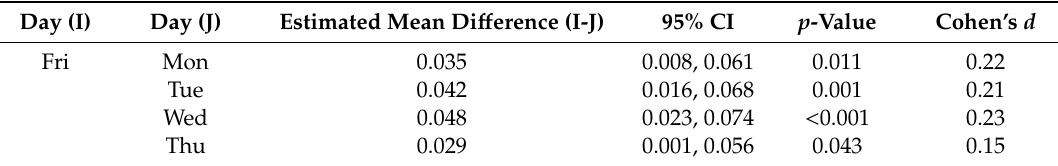
Table A4. Pairwise comparisons of significant estimated mean di ff erences in active SB ratio between weekdays A